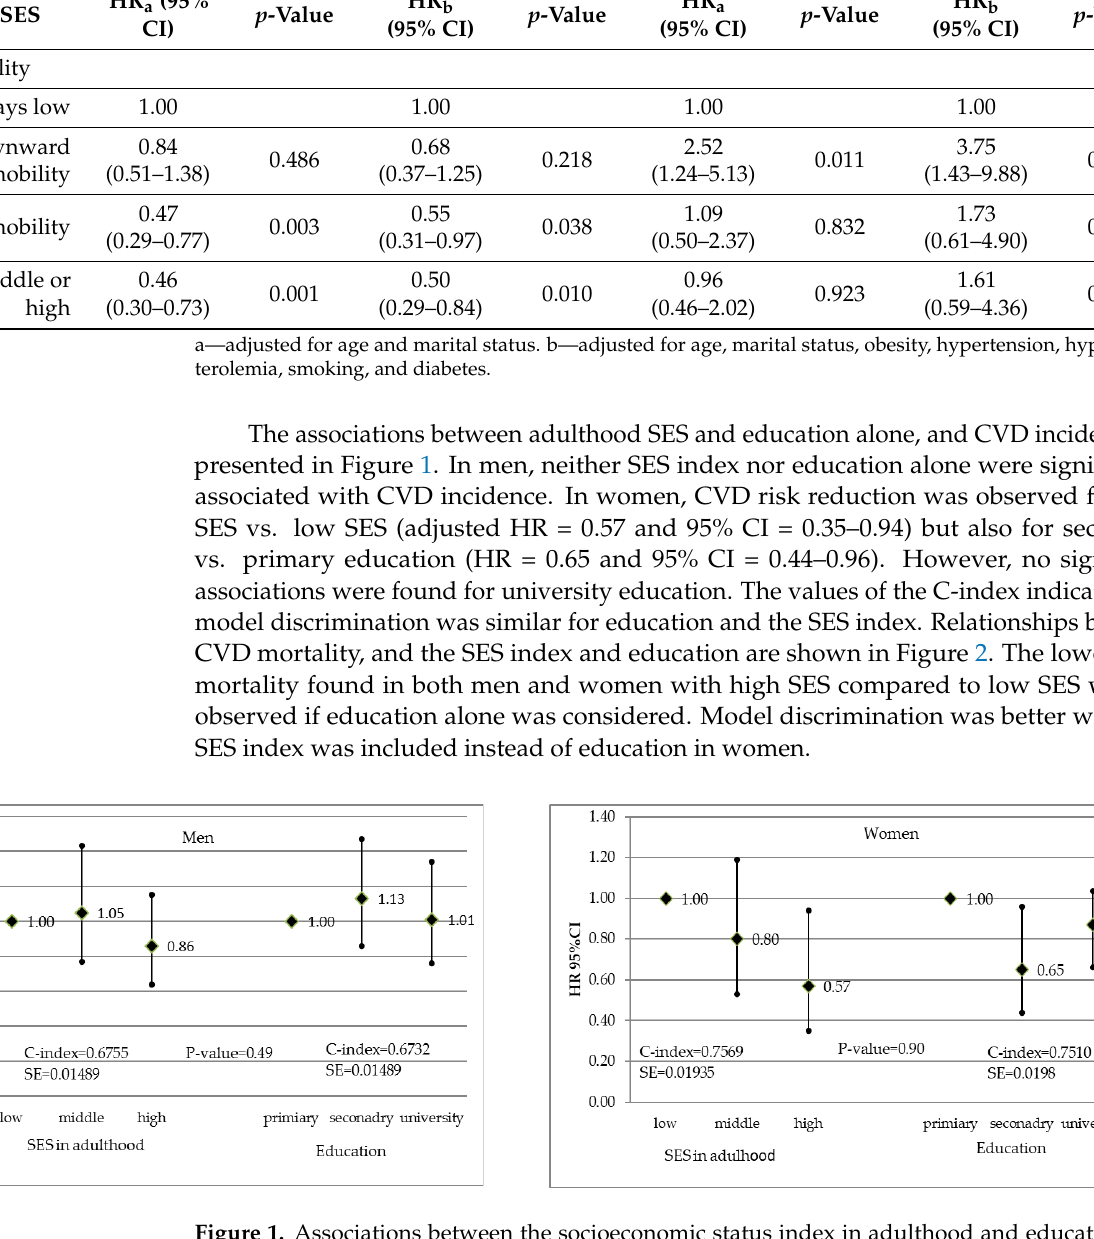
Figure 2. Associations between the socioeconomic status index in adulthood and education, and cardiovascular disease mortality in men and women. Hazard ratios adjusted for age, marital status, obesity, hypertension, hypercholesterolemia, smoking, and diabetes.